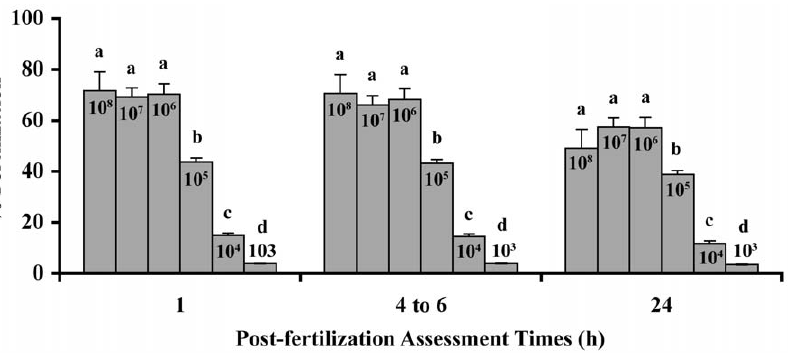
Figure 2. Minimal sperm needed for maximal in vitro fertilization. To test the optimal sperm concentration for zebrafish in vitro fertilization, various working sperm concentrations were assessed. These test concentrations (cells/ml) included 10 8 (N=5), 10 7 (N=21), 10 6 (N=26), 10 5 (N=25), 10 4 (N=25), and 10 3 (N=16) sperm to initiate fertilization in the dishes. The means were significantly different (P , 0.05) between the groups that have different letters (ANOVA). This determined that 10 6 cells/ml was the minimal in vitro sperm concentration needed to achieve maximum fertilization success, below this concentration the fertilization success declined.